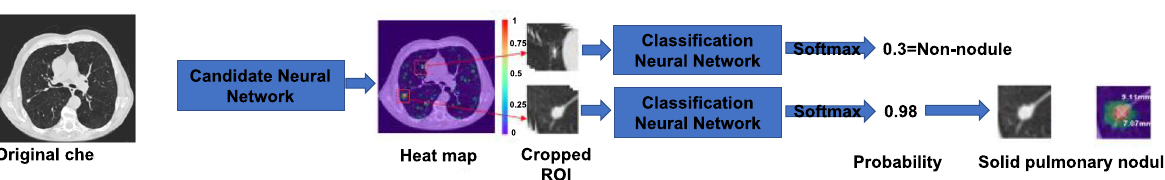
Figure 3. Diagnostic workflow of the two-step modules of the DL algorithm. After analysis by the DL model, the ROI near the right lower lobe on the heat map was confirmed to be a solid pulmonary nodule, and the nodule-like mass in the right upper lobe was eventually confirmed to be a blood